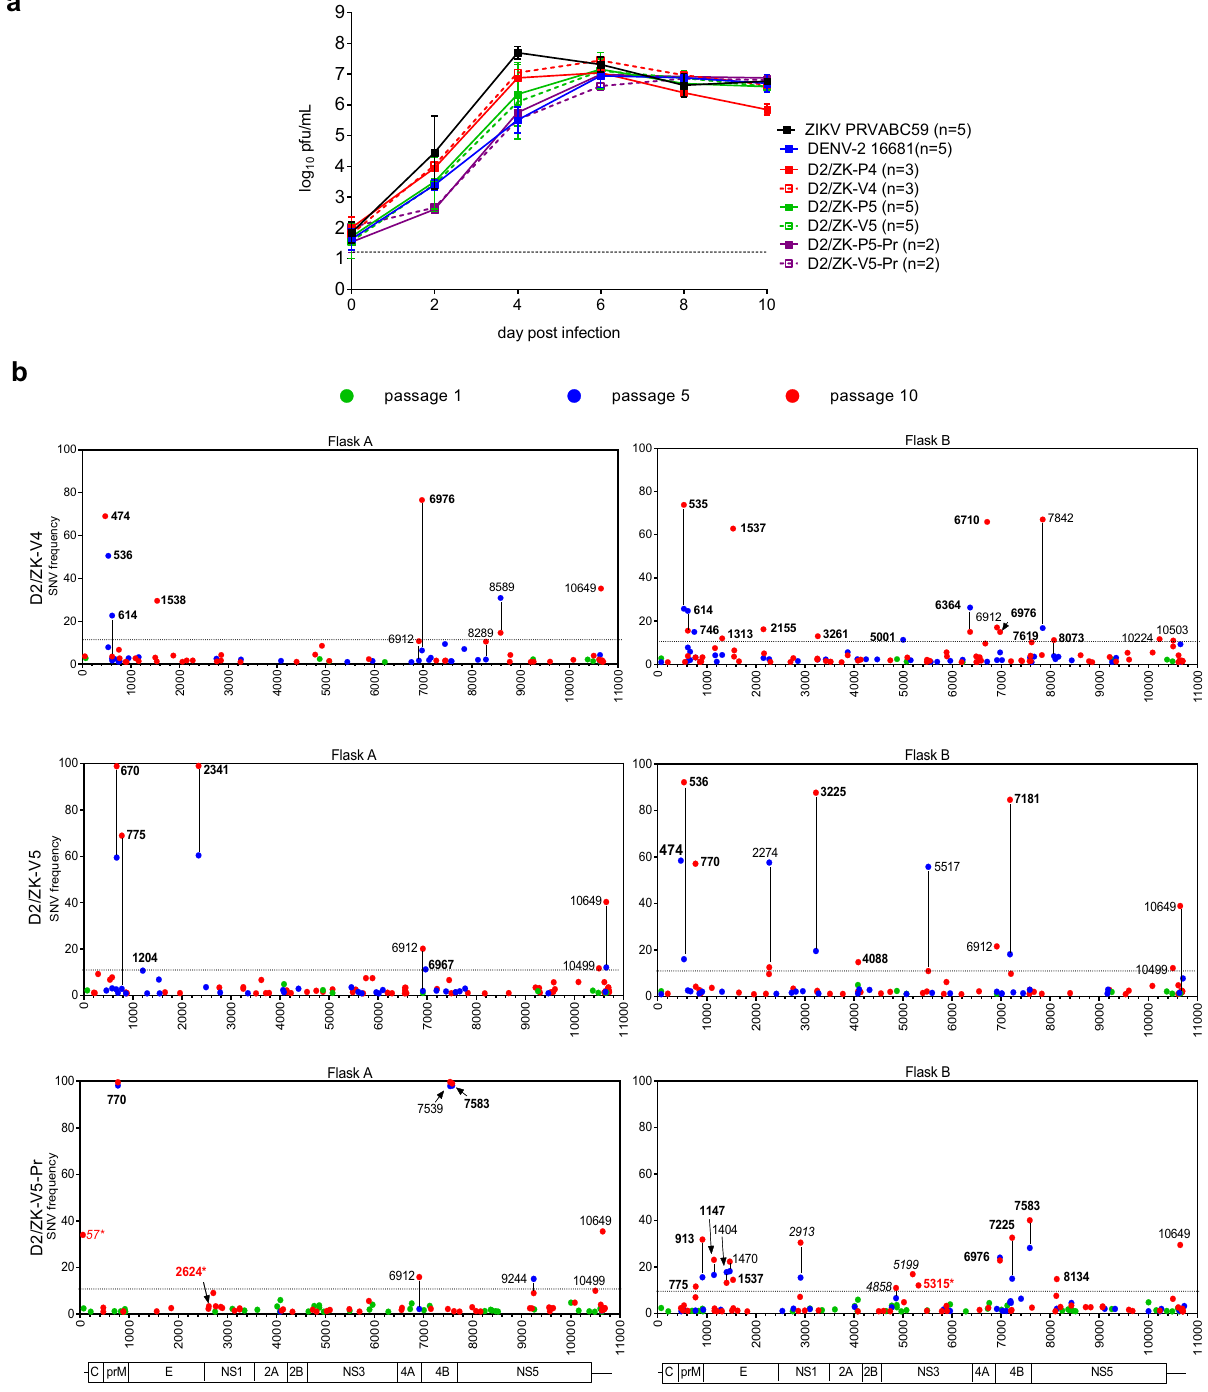
Fig. 2 Growth kinetics and genetic stability of D2/ZK LAV candidates in Vero cells. a Growth kinetics of D2/ZK viruses: geometric mean titers (GMT) and error bars (standard deviation, SD) of each virus group. Sample size ( n ) shown in the symbol legend indicates the number of independent culture fl asks used for each virus. Dashed line represents the limit of detection (LOD) of the plaque assay. b Whole genome NGS of D2/ZK-V4, V5 and V5-Pr viruses at passage 1 (green), 5 (blue) and 10 (red) of 2 independent lineages (Flask A and B). SNVs with frequency ≥ 1% are displayed across the virus genome. SNVs at DENV-2 PDK-53 attenuation loci are highlighted in red font with an asterisk*. Nucleotide positions labeled with black font indicate SNVs ≥ 10% frequency (above dashed line), bold font indicates SNVs resulting in AA change. Vertical line between P5 and P10 indicates SNVs found in both passages of the